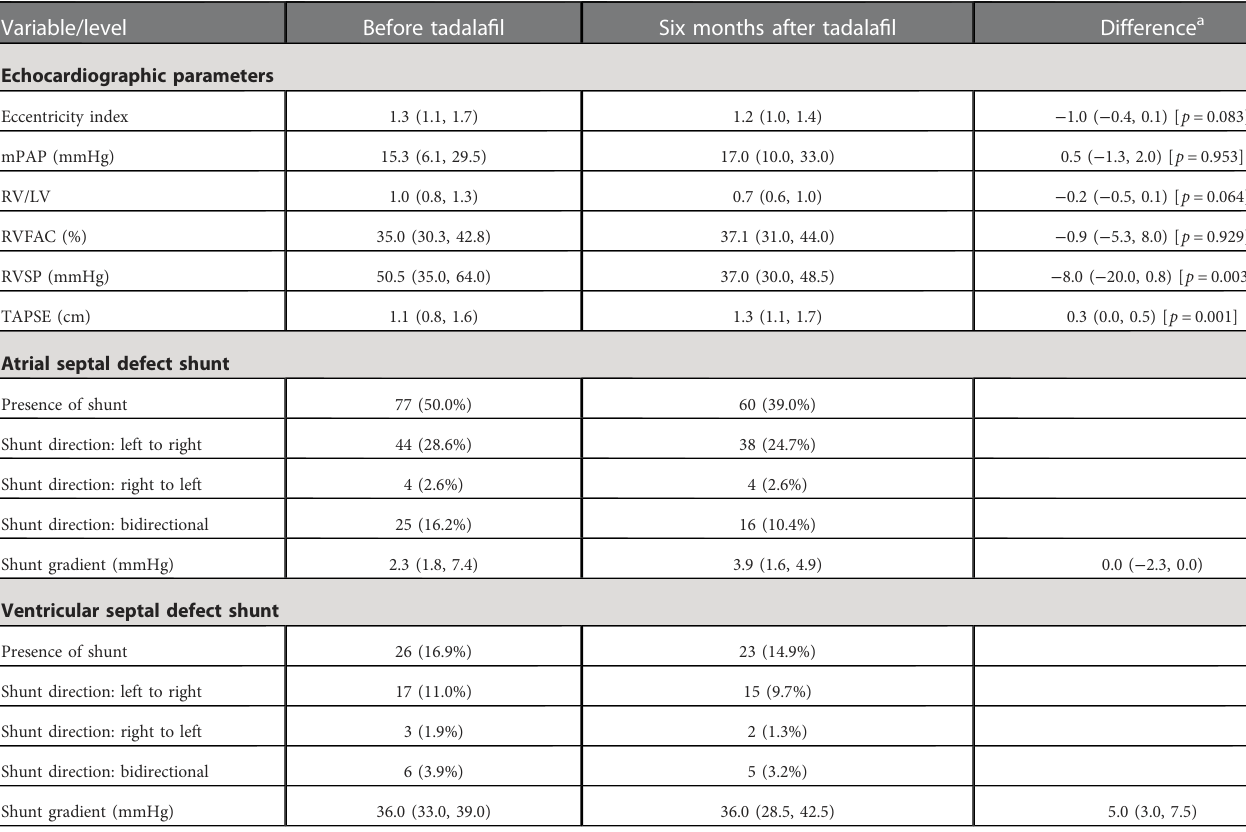
TABLE 4 Echocardiographic measures before and six months after tadala fi l initiation, summarized as median (Q 1 , Q 3 ) or count (%). Variable/level